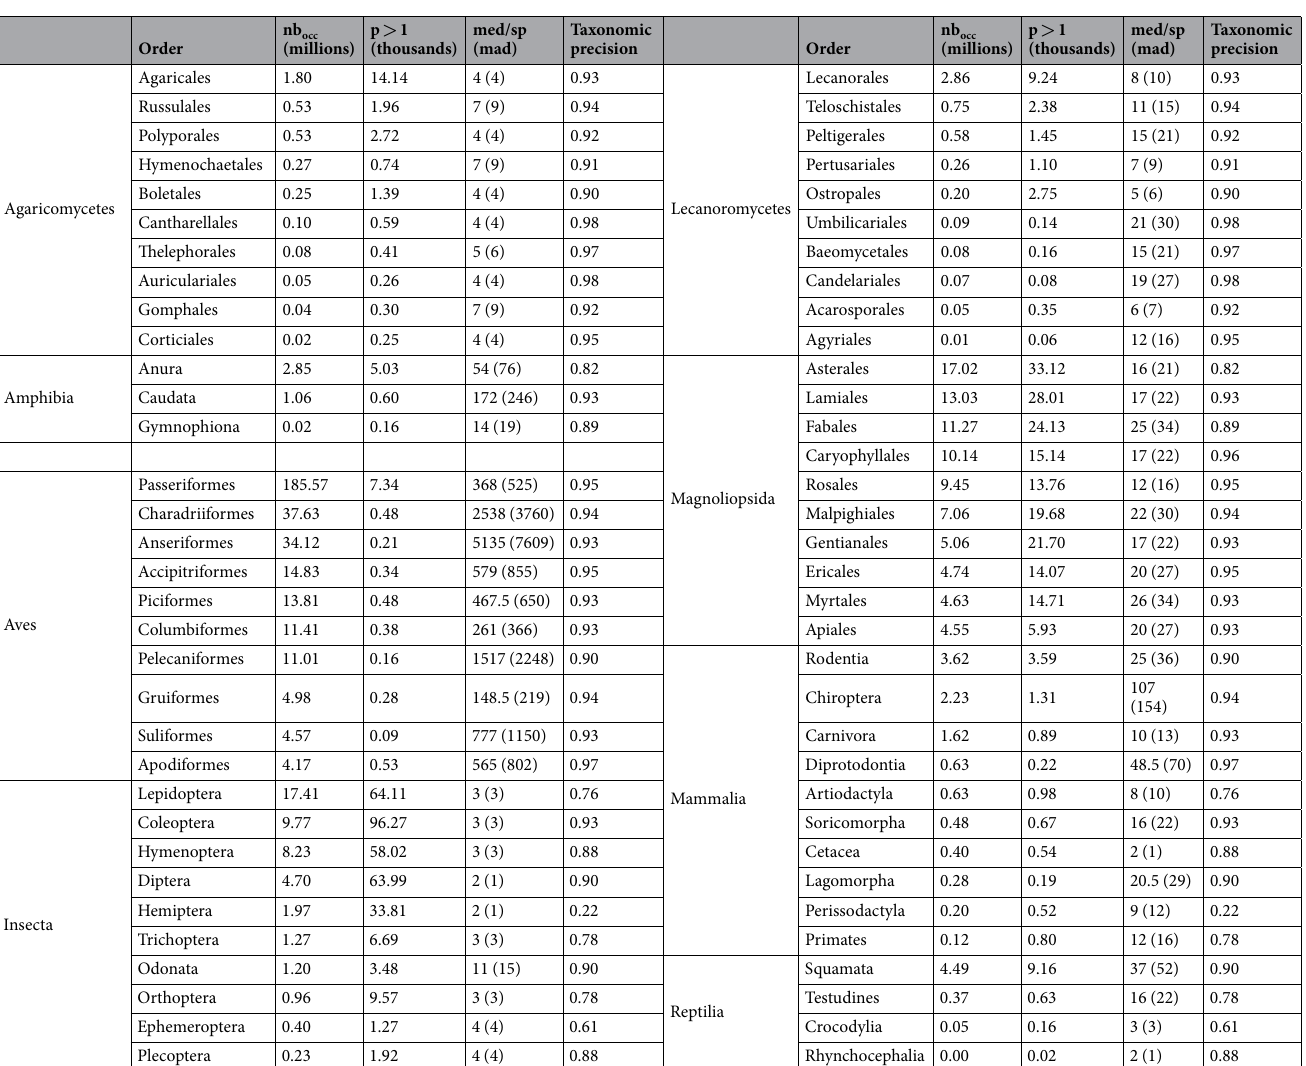
Table 2. Biodiversity occurrence data statistics for the orders (maximum 10) with the most occurrences within eight selected classes. Statistics and abbreviations as in Table